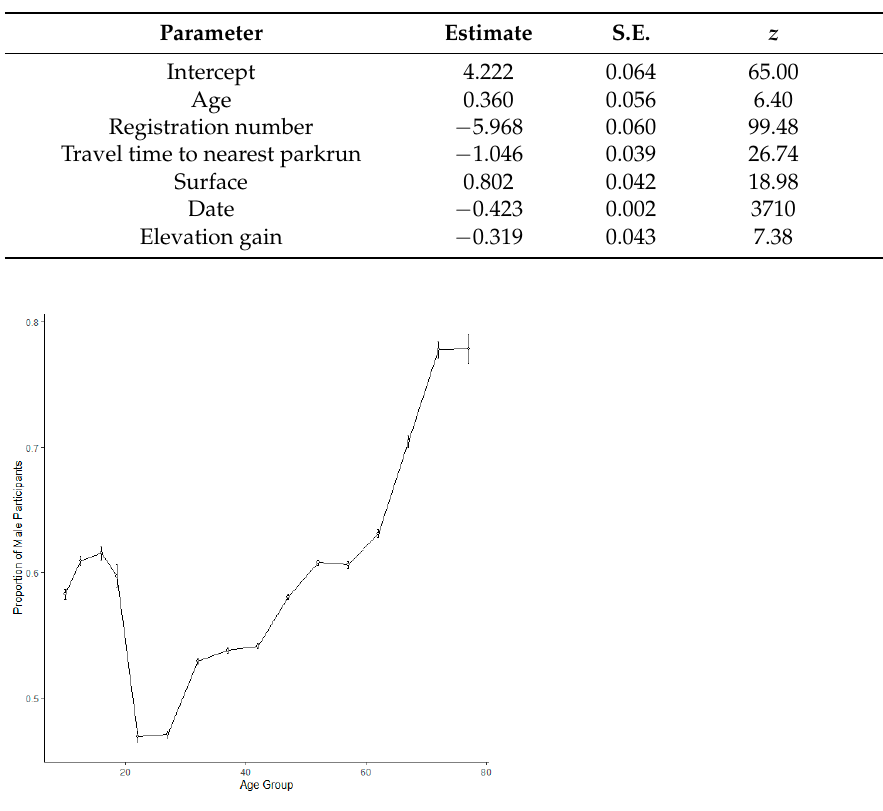
Figure 3. The proportion of male runners in each age cohort at Scottish parkrun events. Error bars represent 95% confidence intervals.